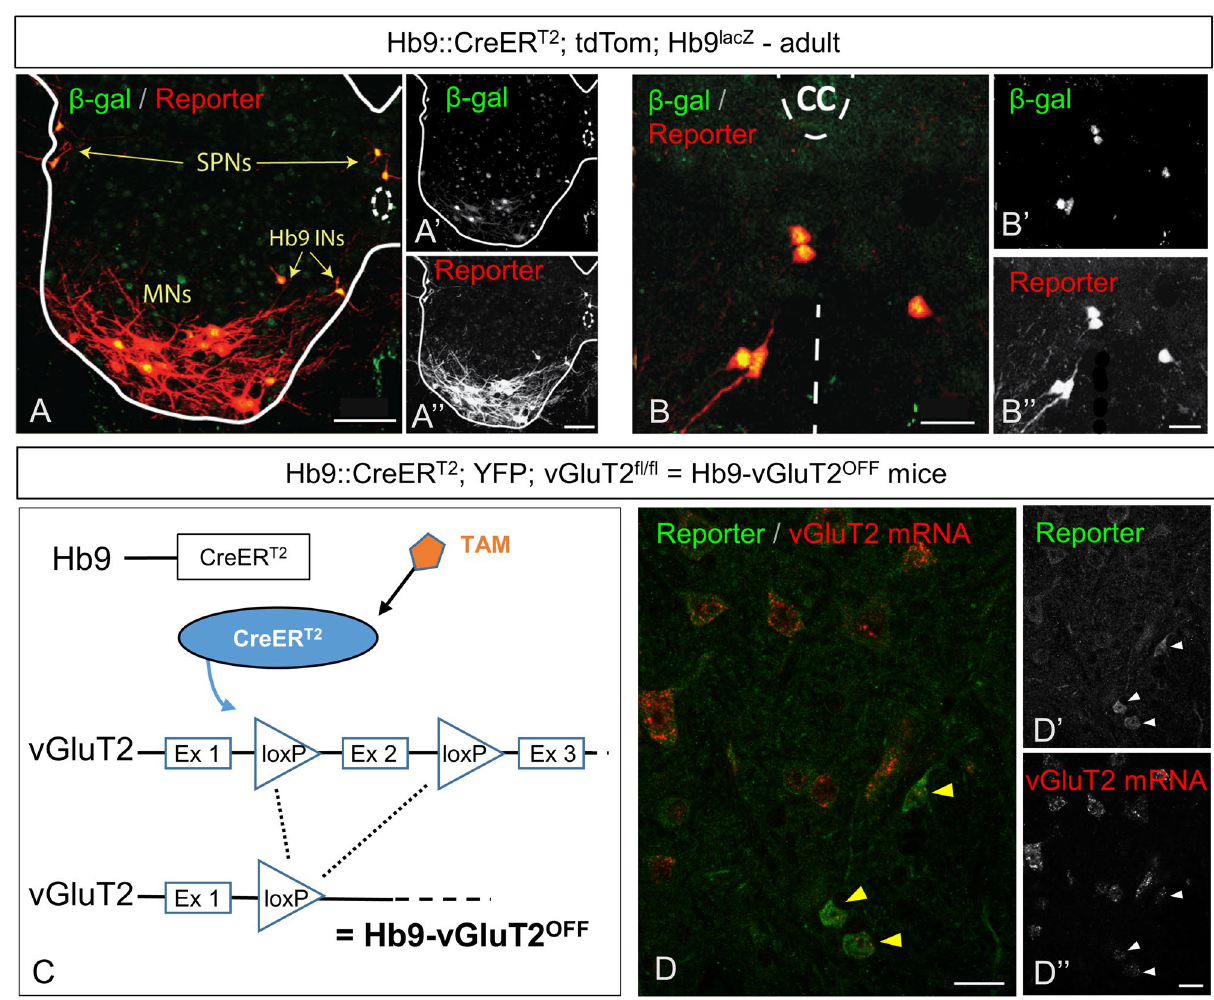
Figure 4. Conditional recombination in adult Hb9::CreER mice. ( A ) Following P5-P7 tamoxifen administration to Hb9 lacZ ;Hb9::CreER;R26-lox-stop-lox-tdTom mice, there is overlap of expression of β-gal and td-Tom reporter in specific neurons: SPNs, MNs, and Hb9 INs. ( B ) Higher magnification image of Hb9 INs in the ventromedial region of upper lumbar spinal segment. ( C ) Illustration of conditional CreER- mediated excision of vGluT2 in Hb9 INs following tamoxifen administration, creating Hb9-vGluT2 OFF mice (TAM: tamoxifen, Ex: exon). ( D ) Fluorescent in situ hybridization showing elimination of vGluT2 mRNA in Hb9::CreER; R26-lox-stop-lox-YFP; vGluT2 fl/fl mice. Hb9 INs (arrowheads) lack vGluT2 mRNA following recombination. Single optical section. Scale bar: ( A ) 50 µm; ( B ) and ( D ) 20